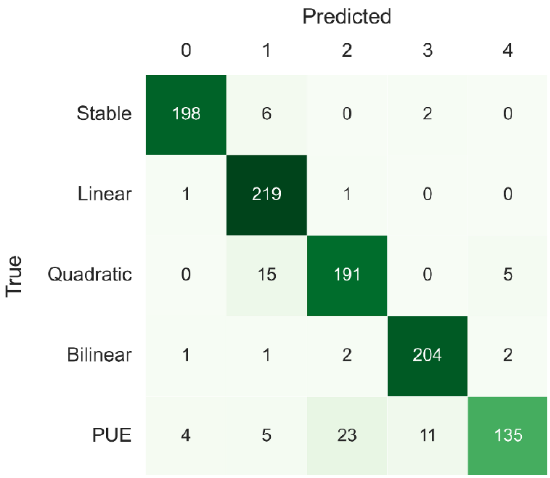
Figure 3 . The confusion matrix of the proposed CNN.